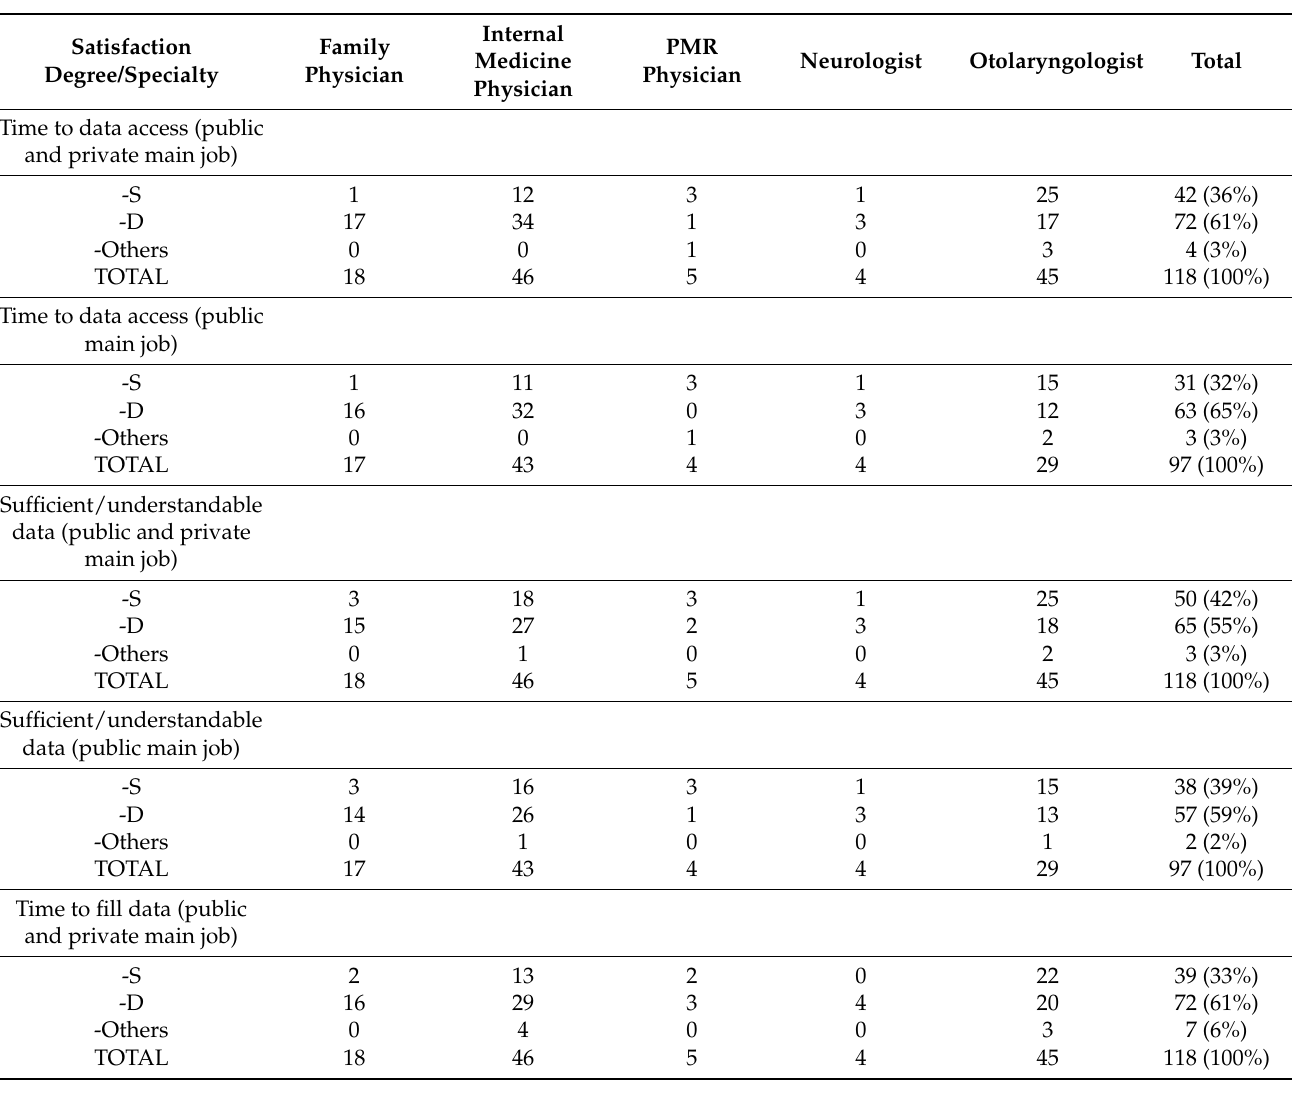
Table 2. Questionnaire: Satisfaction degree with clinical data in the EMR—Context of health care provision for elderly with balance disorders and risk of